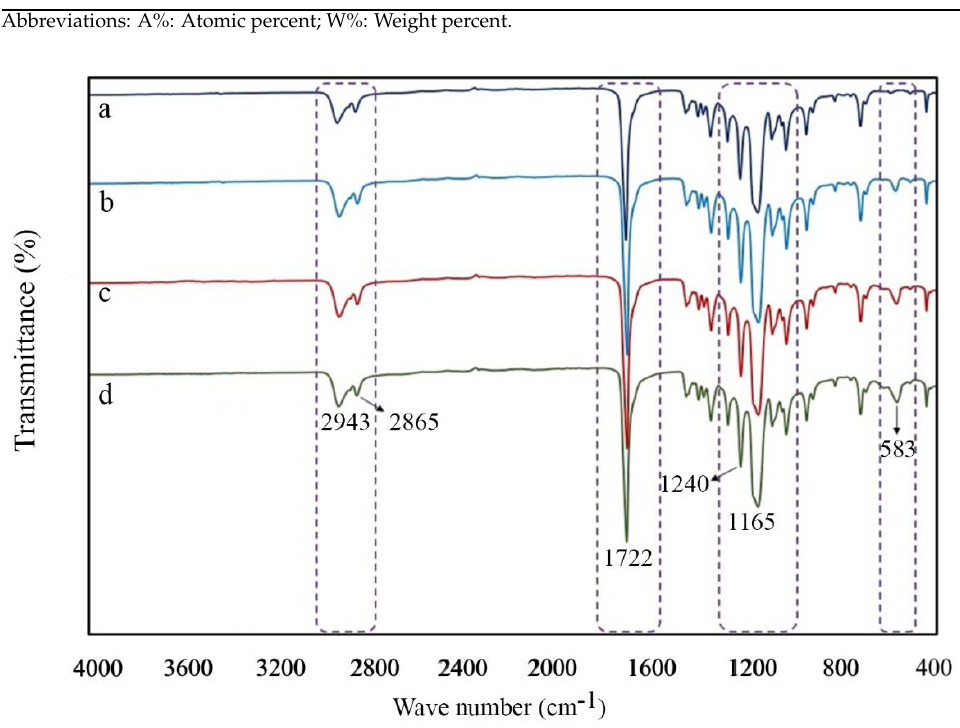
Figure 7. ATR-FTIR spectra of the fibrous scaffolds, ( a ): PCL, ( b ): 3MNP, ( c ): 5MNP, and ( d ): 10MNP.